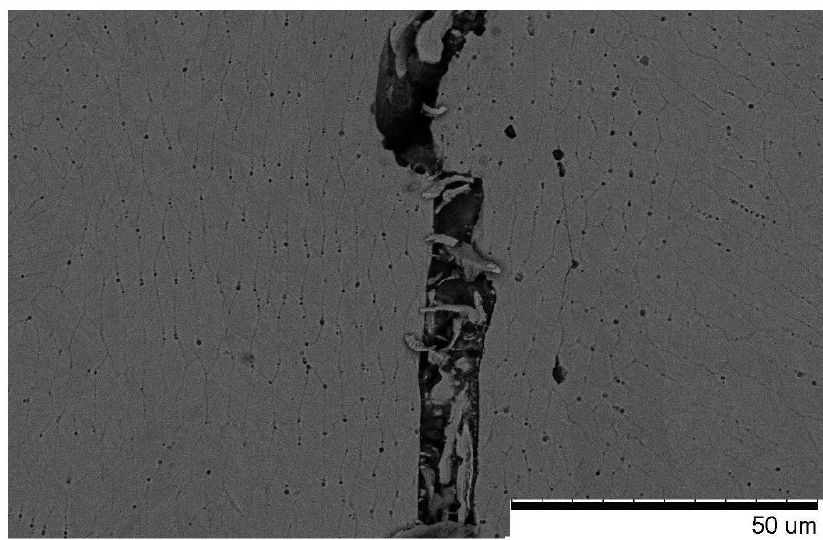
Figure 5. Scanning electron microscopy image of the region near to the center of RT weld (Figure 4a ).